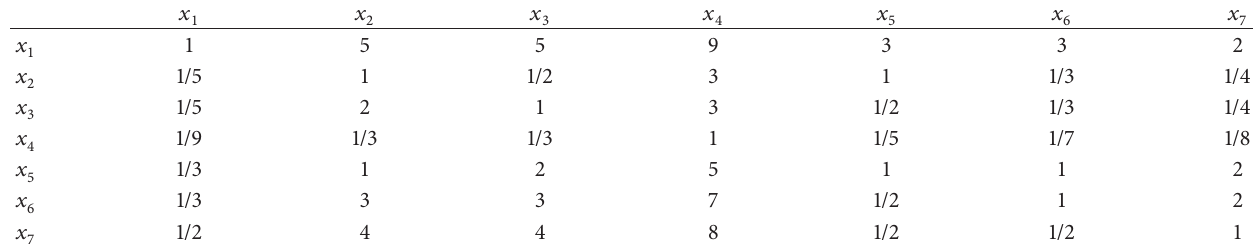
Table 3: The relative importance ratio of evaluation parameters.